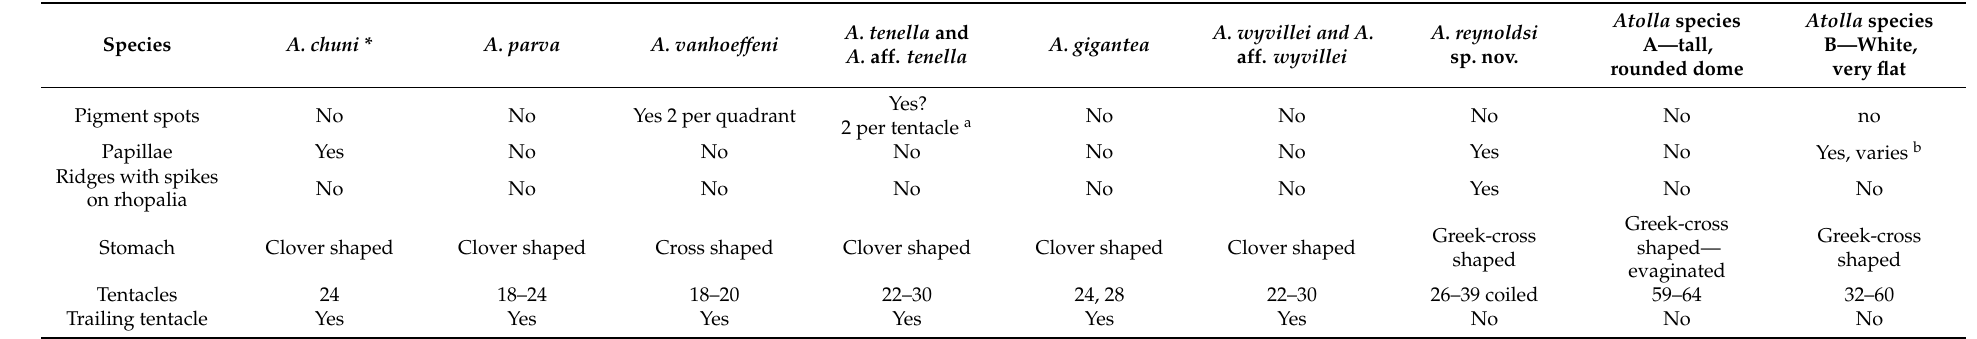
Table A2. Potential diagnostic trait table for species identification of Atolla based on existing keys [8–11] as well as original descriptions and our observations. Potential valid diagnostic traits are highlighted in yellow and we have grouped A. tenella with A . aff. tennella and A . wyvillei with A. aff. wyvillei as the molecular analysis shows that they are similar (Appendix A Table A3). Septa shape (divergent or straight), degree of extension into coronal muscle, and gonad shape are not considered by us to be valid diagnostic